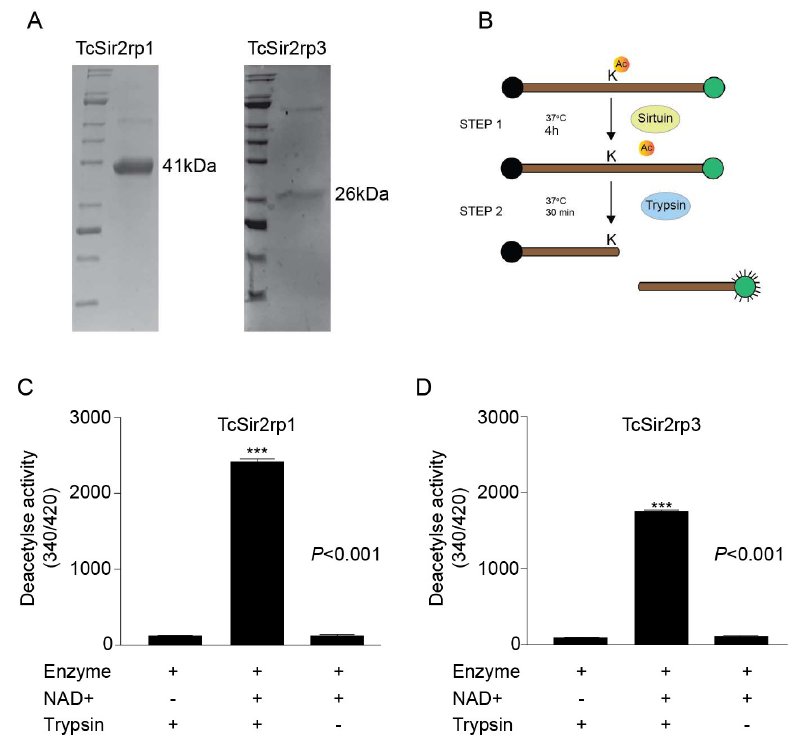
Figure 2. Trypanosoma cruzi recombinant proteins Sir2rp1 and Sir2rp3 in vitro deacetylase activity. ( A ) SDS-PAGE stained with Coomassie brilliant blue of purified TcSir2rp1 and TcSir2rp3 recombinant proteins. ( B ) Schematic representation of the deacetylation assay used to test the TcSir2rp activity. The NAD + -deacetylase activity of TcSir2rp1 ( C ) and TcSir2rp3 ( D ) recombinant proteins. Bars represent